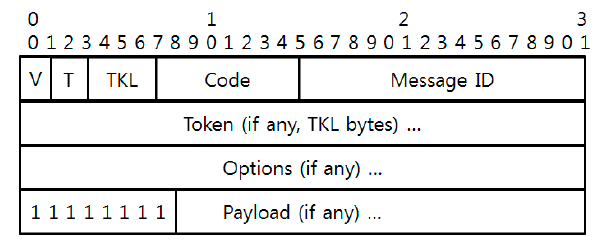
Figure 3. CoAP message format.